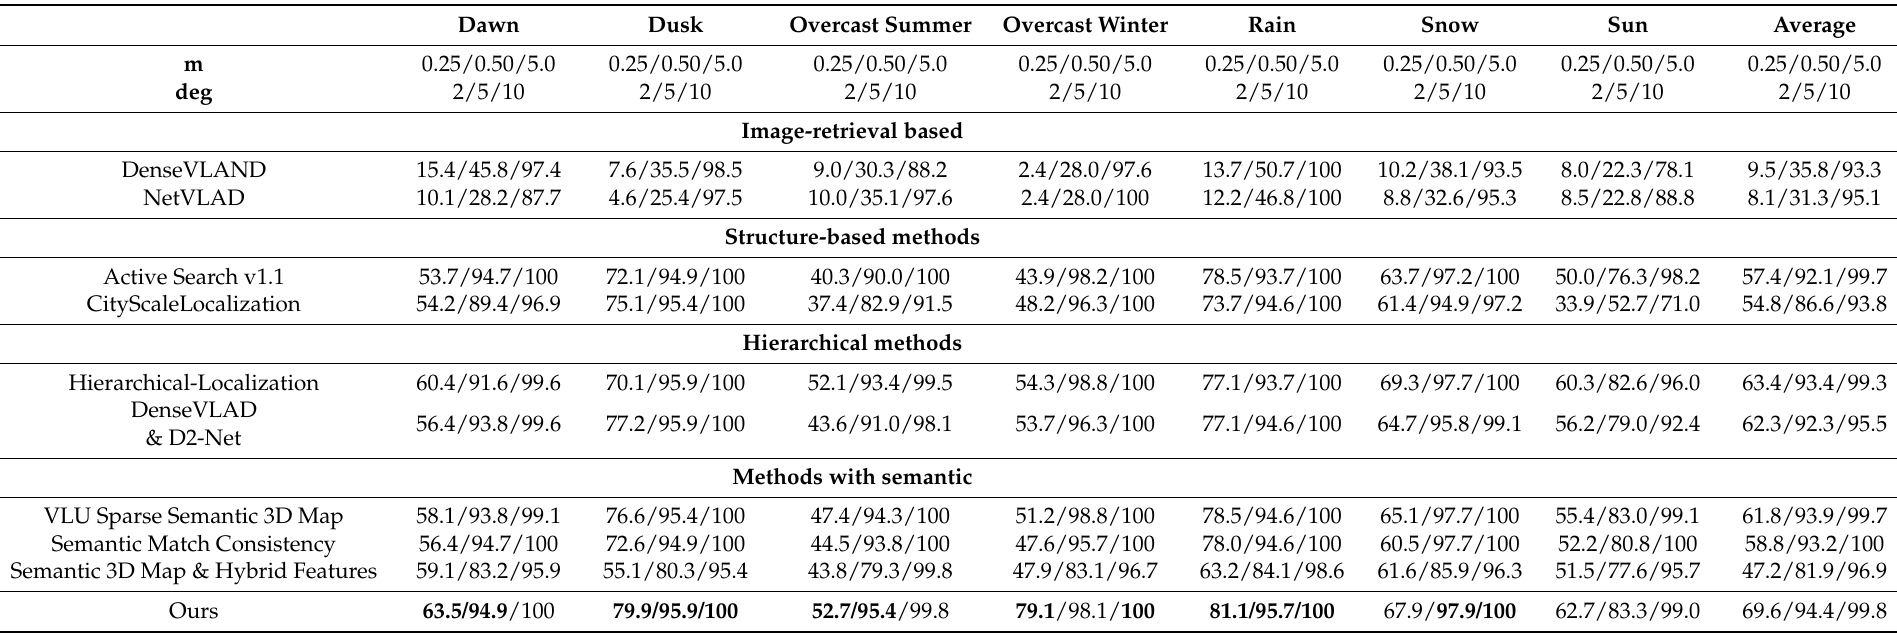
Table 1. Performance of state-of-the-art methods on the RobotCar Seasons dataset. Dawn Dusk Overcast Summer Overcast Winter Rain Snow Sun